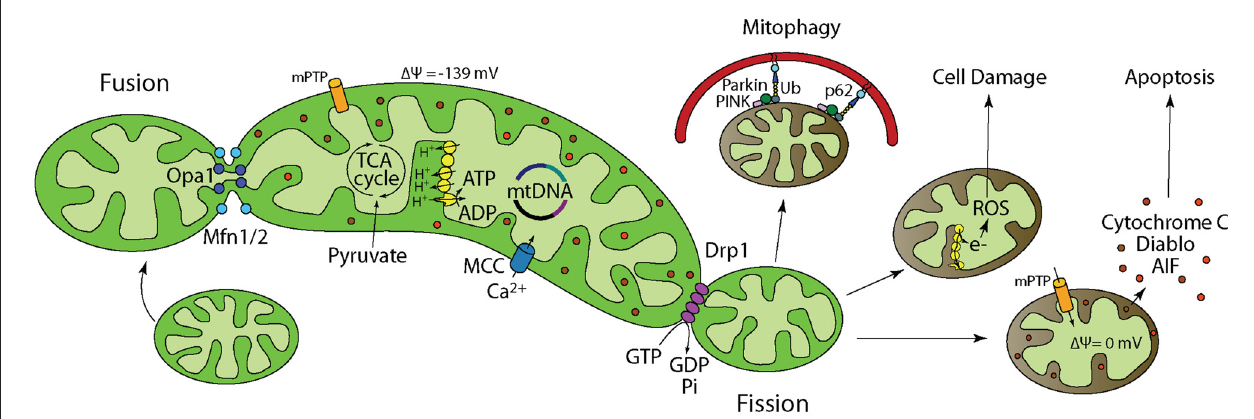
FIGURE 1 | Mitochondrial dynamics and function regulate cellular energy homeostasis, cell survival, growth, and death. Inside of a cell, mitochondria are in a dynamic flux, continuously undergoing fusion and fission to meet cellular energy needs. (1) Fusion is regulated by Optic Atrophy 1 (Opa1) and Mitofusin1/2 (Mfn1/2) and allows for functional complementation and repair of damaged mitochondria. (2) Pyruvate from glycolysis is transported into the mitochondria where pyruvate dehydrogenase catalyzes the decarboxylation of Pyruvate to form Acetyl CoA. Acetyl CoA then enters the TCA cycle. (3) Electromotive force generated by the electron transport chain allows ATP synthesis by the F1-Fo ATP synthase. (4) Mitochondria buffer excess intracellular calcium. When calcium buffering capacity is compromised as a result of mitochondrial damage/depolarization, calcium accumulates in the cytosol and activates degradative enzymes such as calpain and phospholipases that break down cellular proteins and membrane leading to death. (5) Fission is regulated by dynamin-related protein 1 (Drp1) and allows for mitochondria that cannot be repaired to be isolated followed by degradation through mitophagy. Fission is also important for subcellular distribution and transportation of mitochondria based on energy needs in certain areas of the cell. (6) Electrons leaked from the electron transport chain interact with molecular oxygen to generate reactive oxygen species (ROS) that not only damage mitochondrial membrane, mitochondrial DNA (mtDNA), and proteins, but also their cellular counter parts. Neurons have limited defense against oxidative damage and are highly vulnerable to ROS. (7) Mitochondria play a prominent role in apoptotic cell death. Damaged/depolarized mitochondria release cytochrome c and apoptosis inducing factor (AIF) that trigger cell death by activating